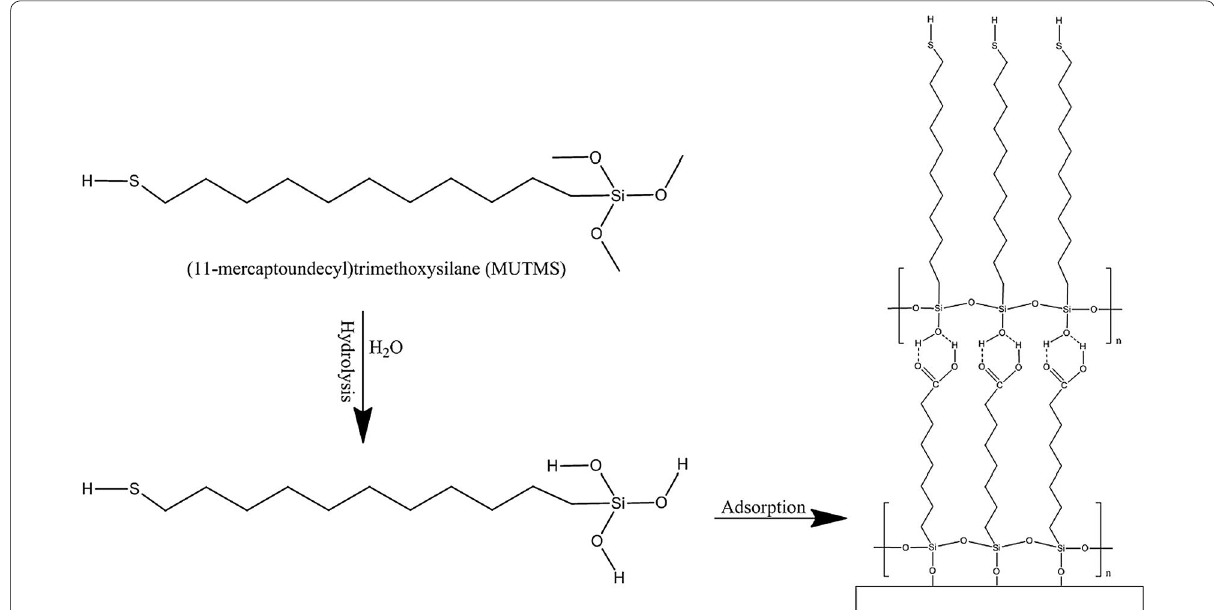
Fig. 3 Schematic representation of the construction of a MUTMS monolayer on the OTSpd